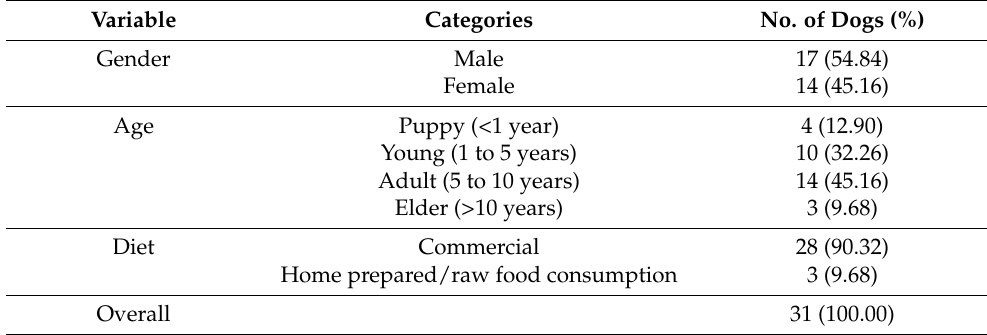
Table 1. Epidemiological data recovered for the 31 boxer samples